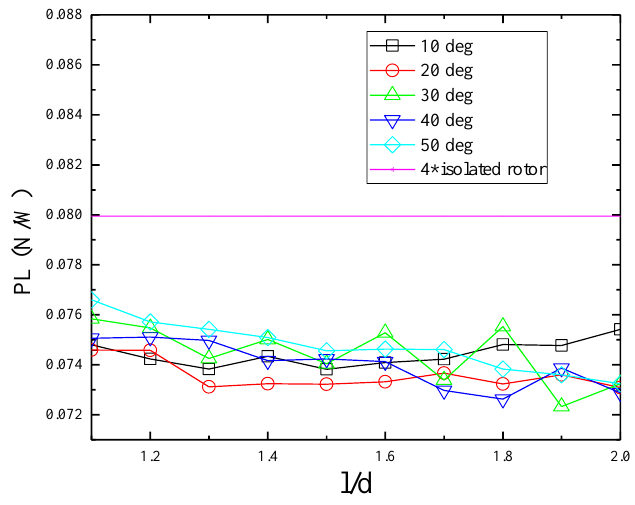
Figure 18. Power-loading of non-planar quadrotor.